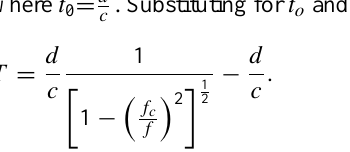
Fig. 1. Typical waveform of sferic field Figure 1 Typical waveform of sferic field pattern.